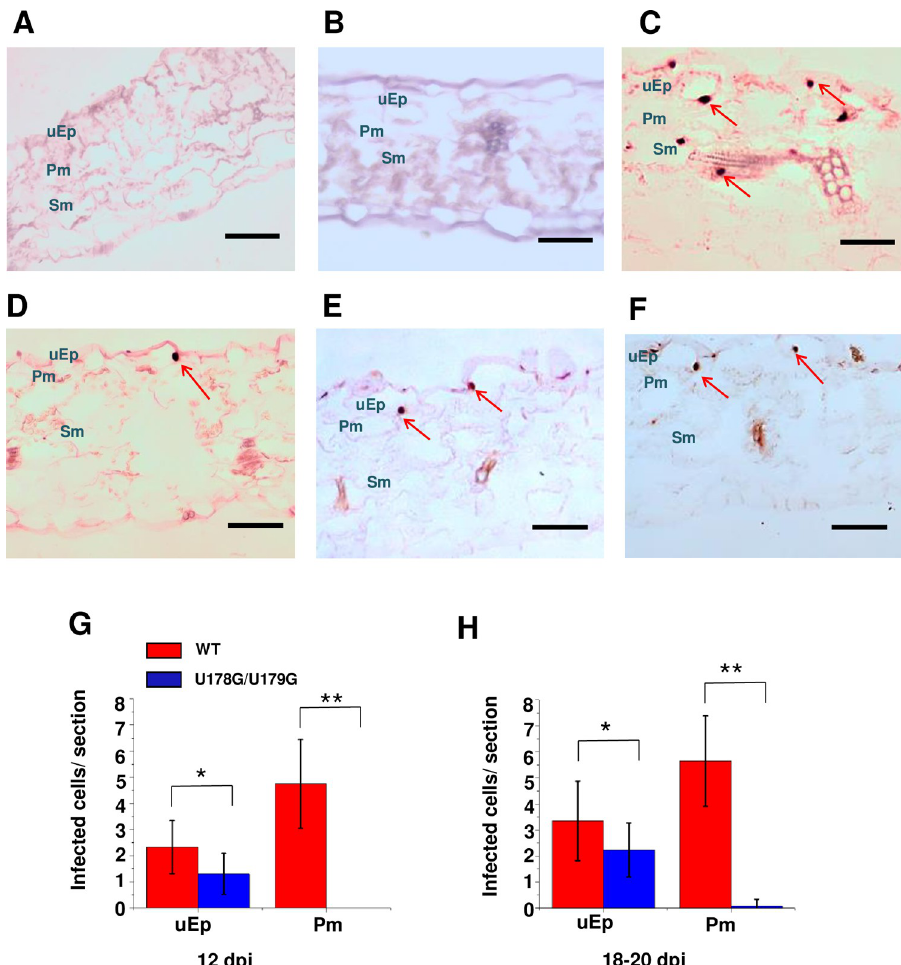
Fig 7. U178G/U179G fails to exit epidermal cells in rub-inoculated leaves. Transverse section (12 μ m) in situ hybridization of (A) mock inoculated leaves (negative control), (B) leaves inoculated with replication defective A271G/ C273G (negative control), (C) wild type PSTVd (positive control), and (D-F) U178G/U179G. Images for PSTVd WT and U178G/U179G are representative of more than 200 sections. Purple dots (red arrows) are viroid hybridization signals in nuclei. uEp, upper epidermis; Pm, palisade mesophyll; Sm, spongy mesophyll; lEp, lower epidermis. Bars = 100 μ m. (G and H) Number of infected cells per leaf section (-1 x 0.15 mm) in the upper epidermis (uEp) or adjacent palisade mesophyll (Pm) of plants inoculated with WT PSTVd (red) or U178G/U179G (blue) at 12 dpi (G) and 18–20 dpi (H). Data were compiled from 40 sections obtained from 20 infected plants. Asterisks indicate significant differences (p < 0.05 � ; p < 0.01 �� ) as determined by Student’s t test. Bars indicate standard error of the